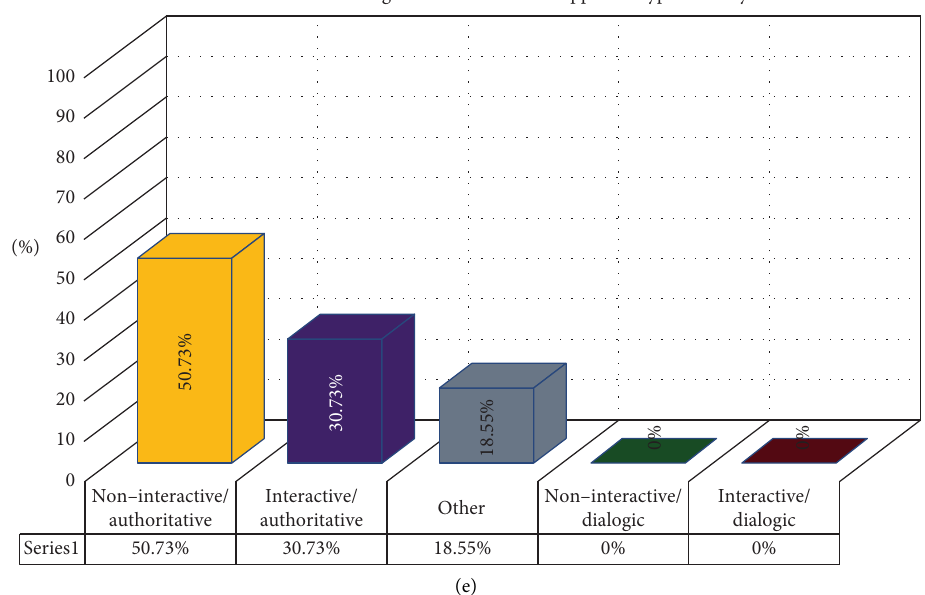
Figure 3: Percentages of communicative approach types used by T1, T2, T3, T4, and T5. (a) Percentages of communicative approach types used by T1. (b) Percentages of communicative approach types used by T2. (c) Percentages of communicative approach types used by T3. (d) Percentages of communicative approach types used by T4. (e) Percentages of communicative approach types used by T5.